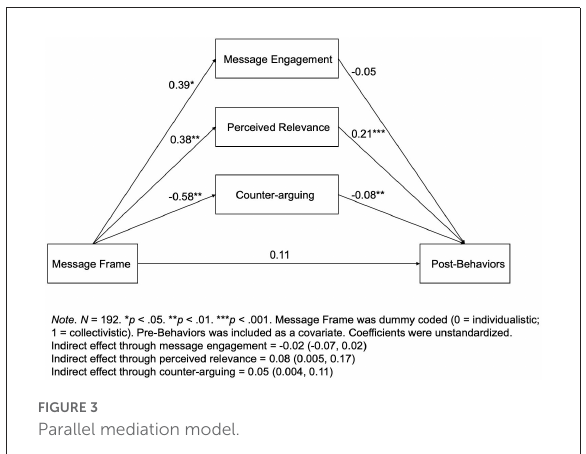
FIGURE3 Parallel mediation